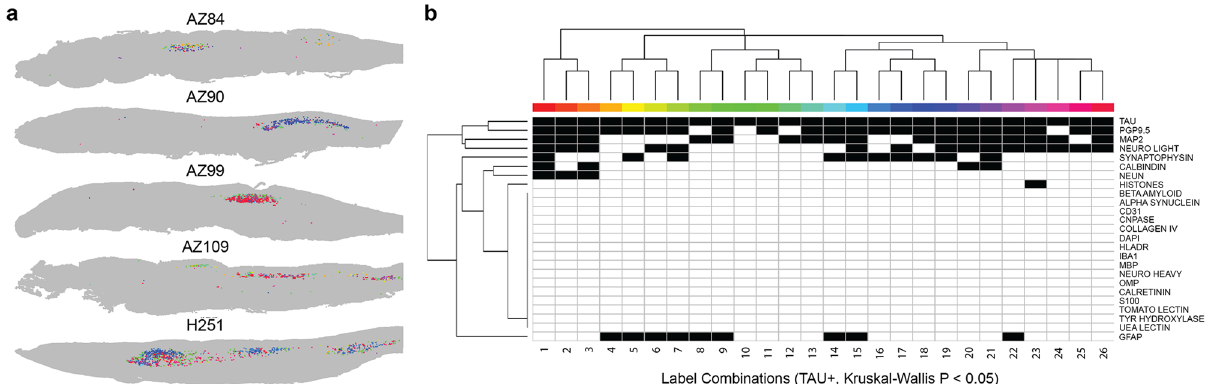
Fig. 6 Tau string analysis for AD cases. The combinations of markers that co-occur with tau were investigated by generating a binary string marker signature. To do this, a Poisson P value was determined for each marker and each bin in the ‘ pseudo ’ count matrix and the bins with a P value < 0.05 were coded as ‘ 1 ’ while the rest were ‘ 0 ’ . For each bin, the binary values for each marker were concatenated into a string and the frequency of each string was tested for differences between bulbs using a Kruskal-Wallis test. Strings with a p value < 0.05 were determined to be differential between bulbs and plotted here. a Slide plots of differentially expressed tau + pixel bins plotted according to their x-y coordinates for each AD case, coloured by tau string identity. These tau + bins are in discrete areas of the bulb that correspond to the AON. b Heat map indicating the marker combinations that are present in the differentially expressed strings containing tau. Various permutations of the same eight markers are determined to be differentially